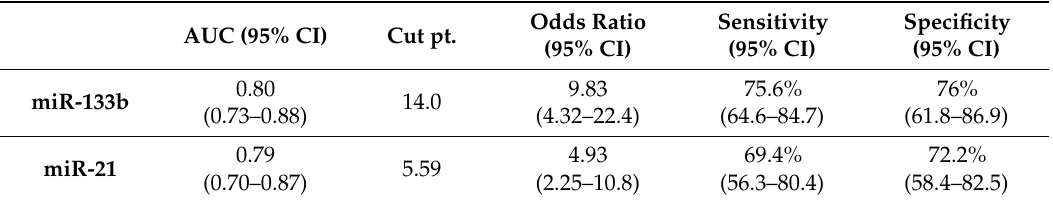
Table 2. Receiver operating characteristic curve (ROC) analysis of miR-133b and miR-21 for their diagnostic potential for coronary artery disease. AUC (95% CI) Cut